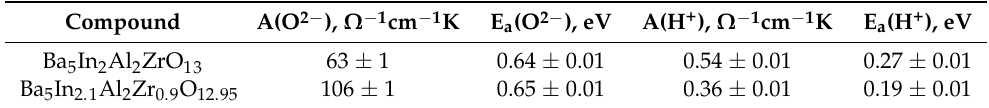
Table 2. Comparison of the activation energy and pre-exponential term of Ba 5 In 2 Al 2 ZrO 13